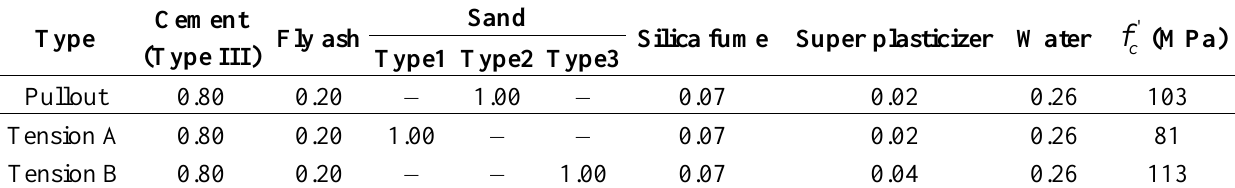
Table 1. Composition of matrix mixtures by weight ratio and compressive